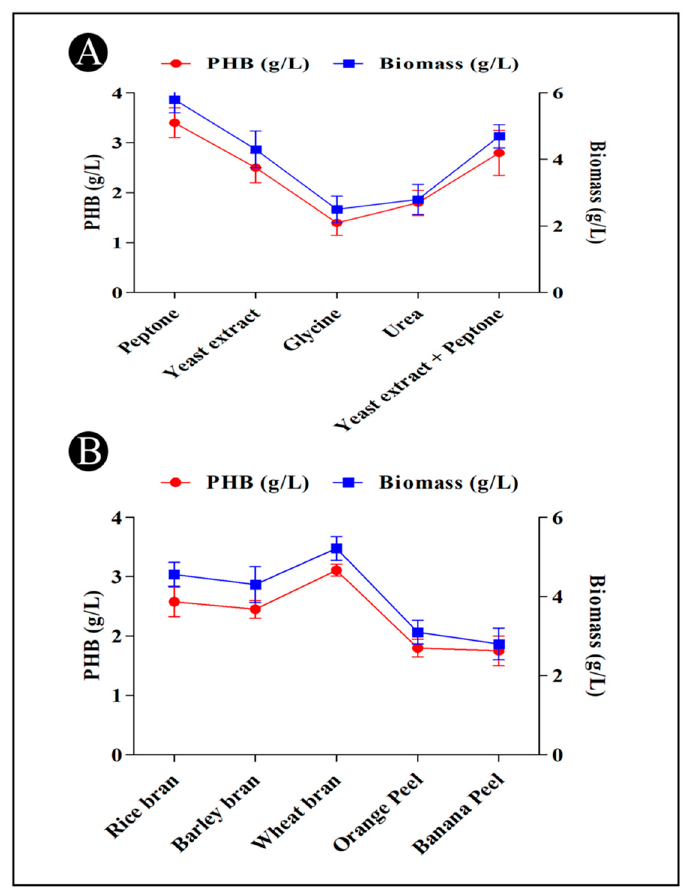
Figure 5. ( A ) E ff ect of di ff erent nitrogen sources on the PHB production by the B. fl exus strain HSA3. ( B ) Effect of different cheap agricultural wastes on the PHB production by the B. flexus strain ( B ) E ff ect of di ff erent cheap agricultural wastes on the PHB production by the B. fl exus strain HSA3.